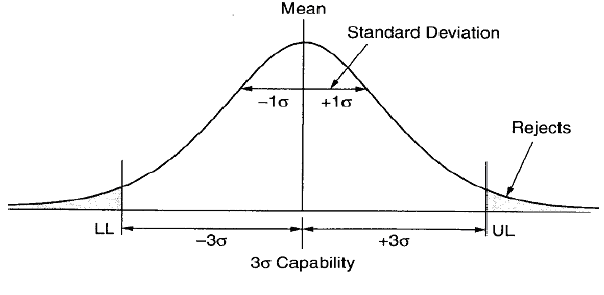
Figure 3 Frequency plot of size distribution for a process with random